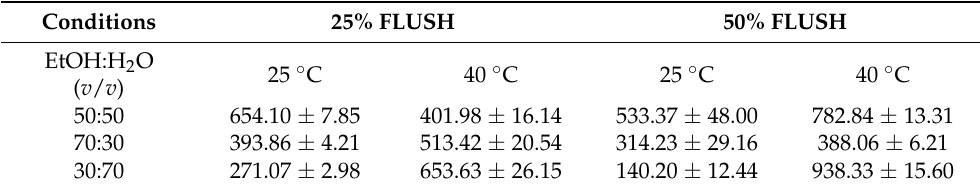
Table 3. Phloridzin content ( µ g/g fresh AP, mean ± SD n = 2) obtained with